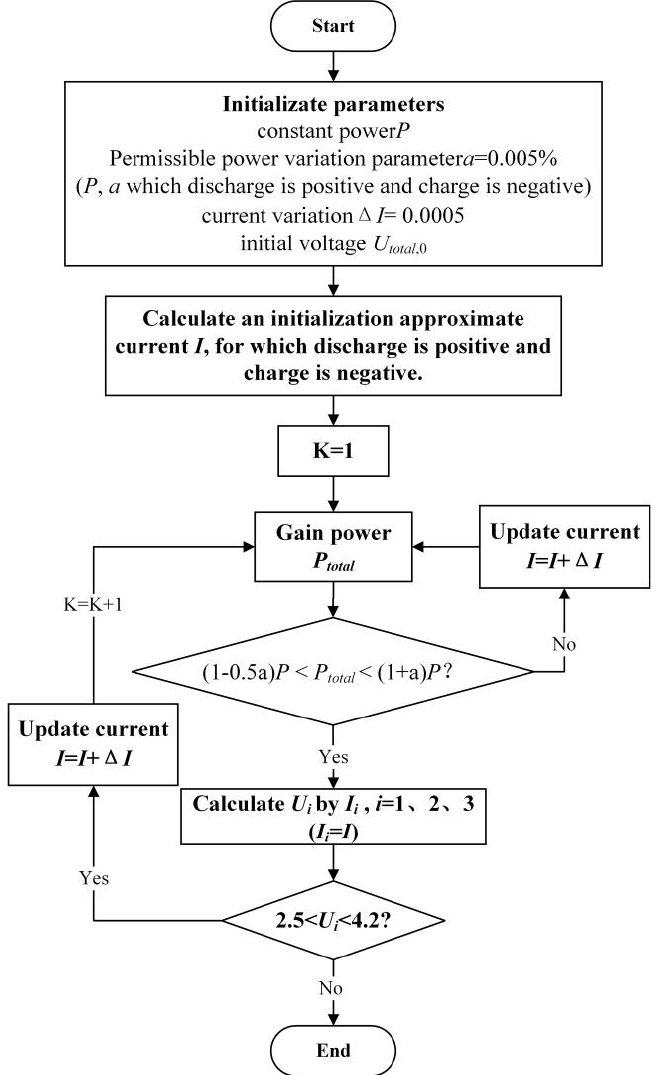
Figure 5. Schematic diagram of battery characteristic prediction under constant power conditions.